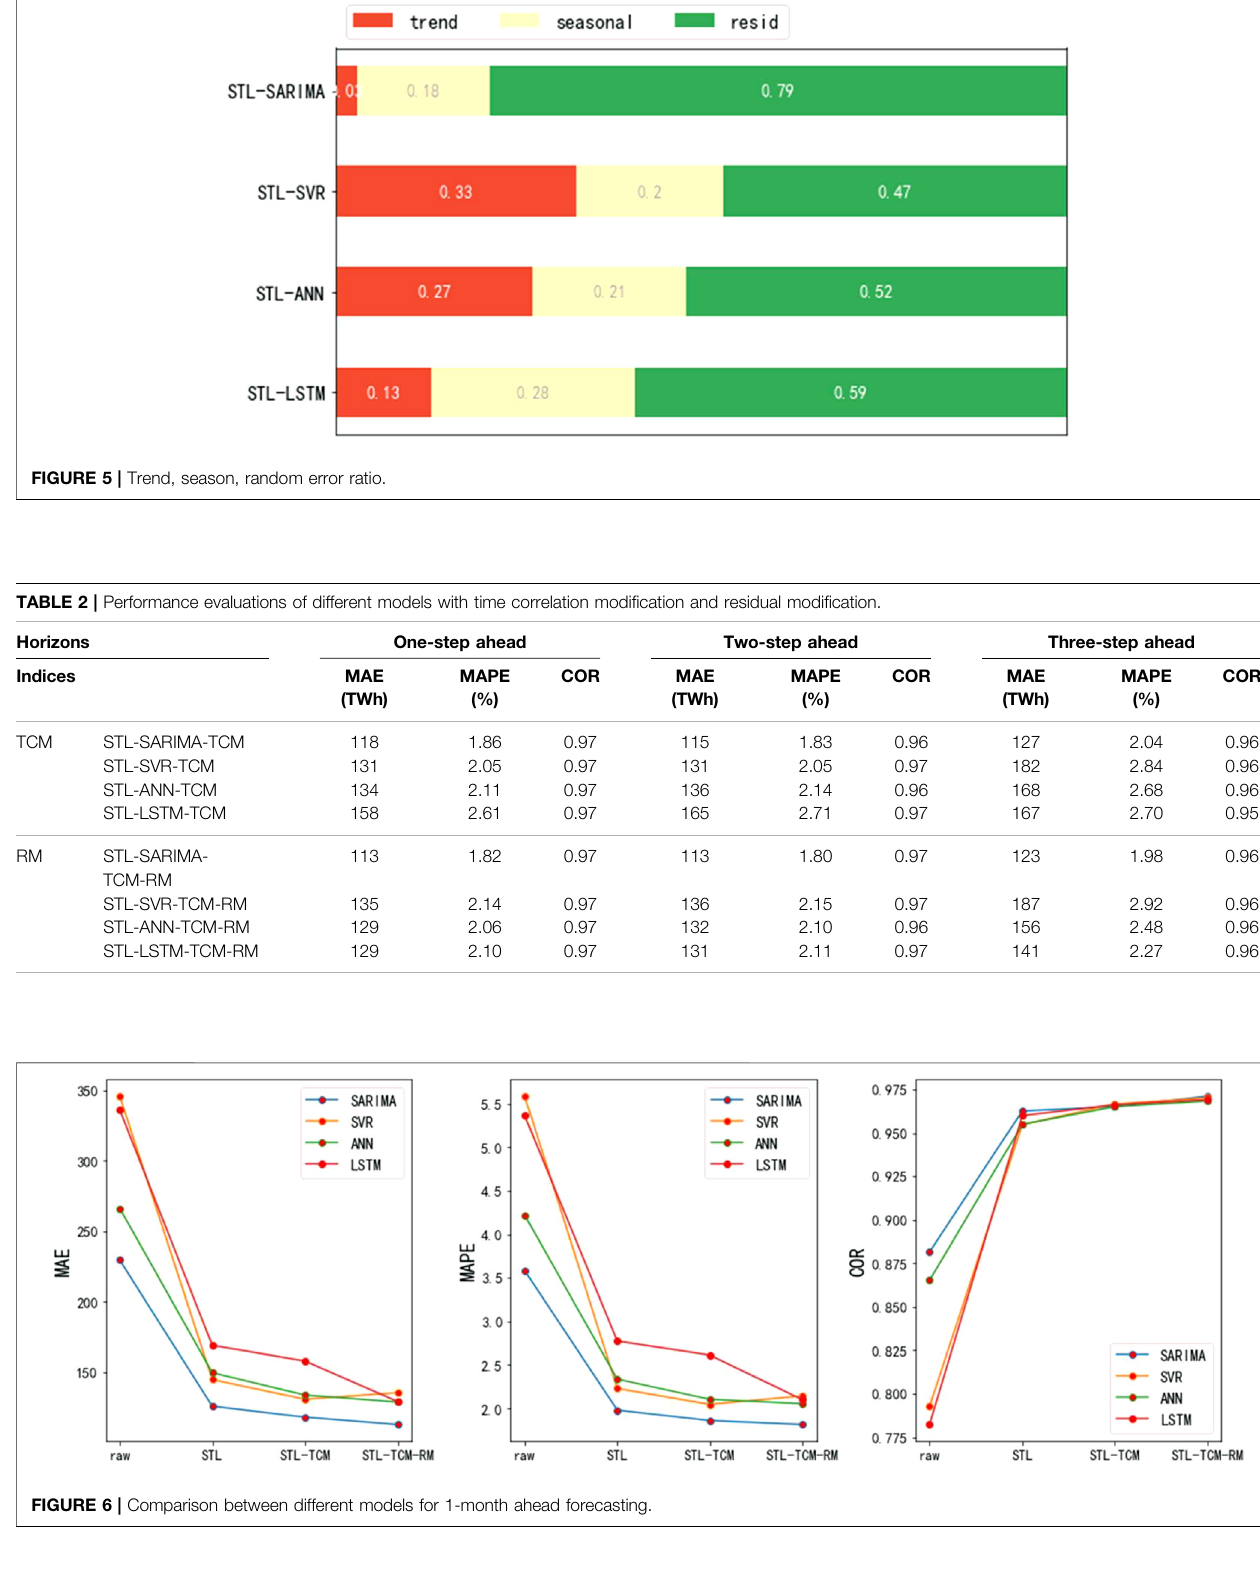
Frontiers in Energy Research |